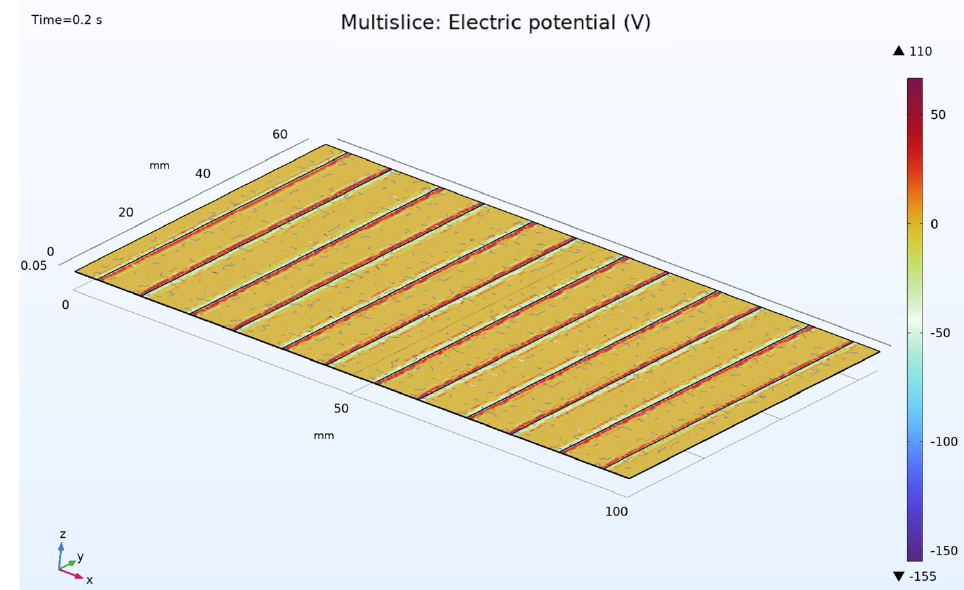
Figure 10. Electric potential (V) simulation on COMSOL ®